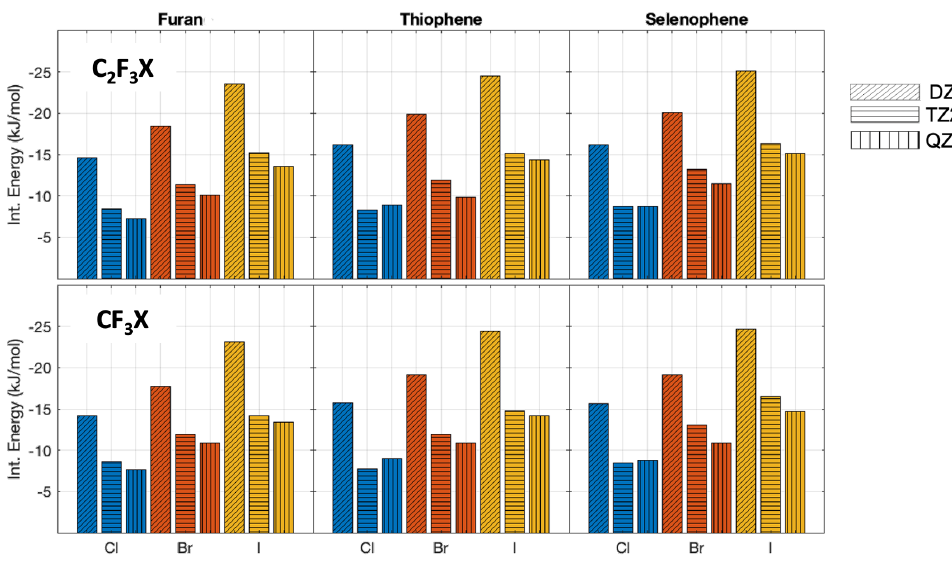
Figure 3. PBE0 − dDsC interaction energies (without zero-point vibrational energy correction) with different basis sets for the complexes oriented in perpendicular. The halogen atoms are depicted with the following colormap: chlorine blue, bromine red, and iodine yellow. The DZP basis set is represented with slanted lines, the TZ2P with horizontal lines, and QZ4P with vertical